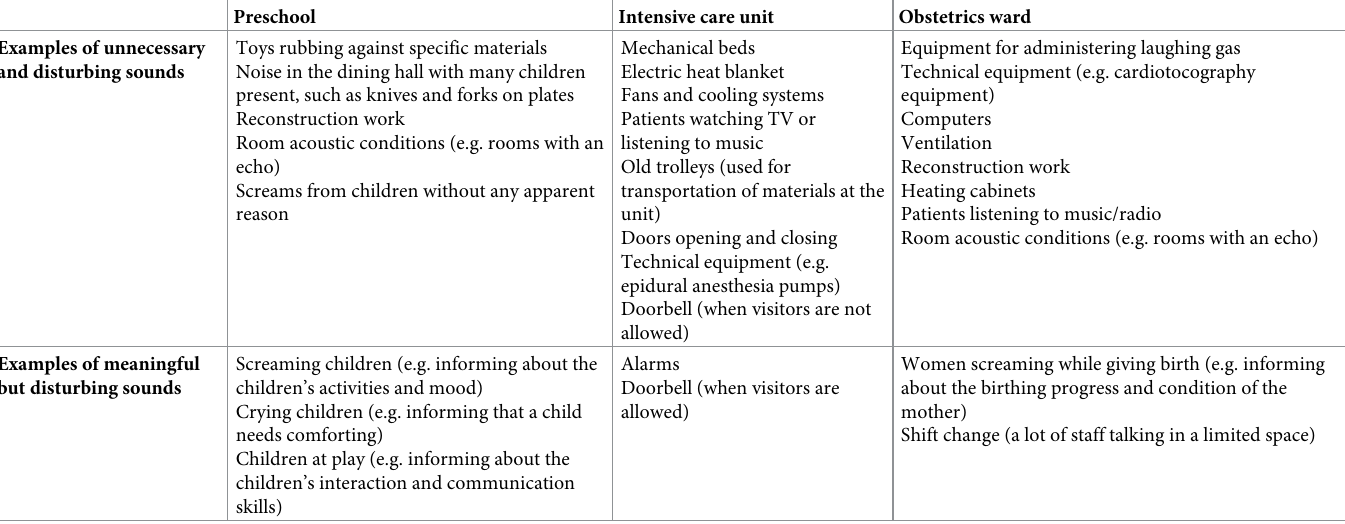
Table 4. Examples of unnecessary and disturbing sounds, and of meaningful but disturbing sounds at the